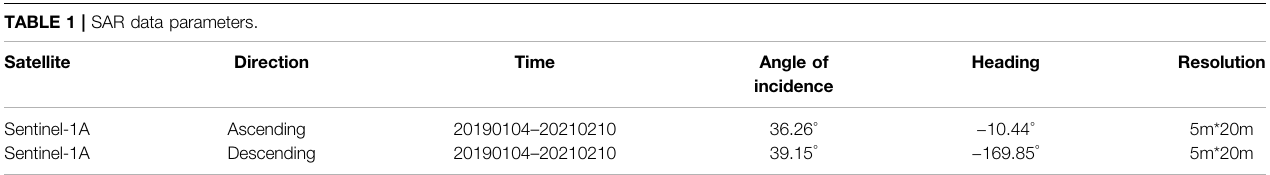
TABLE 1 | SAR data parameters.